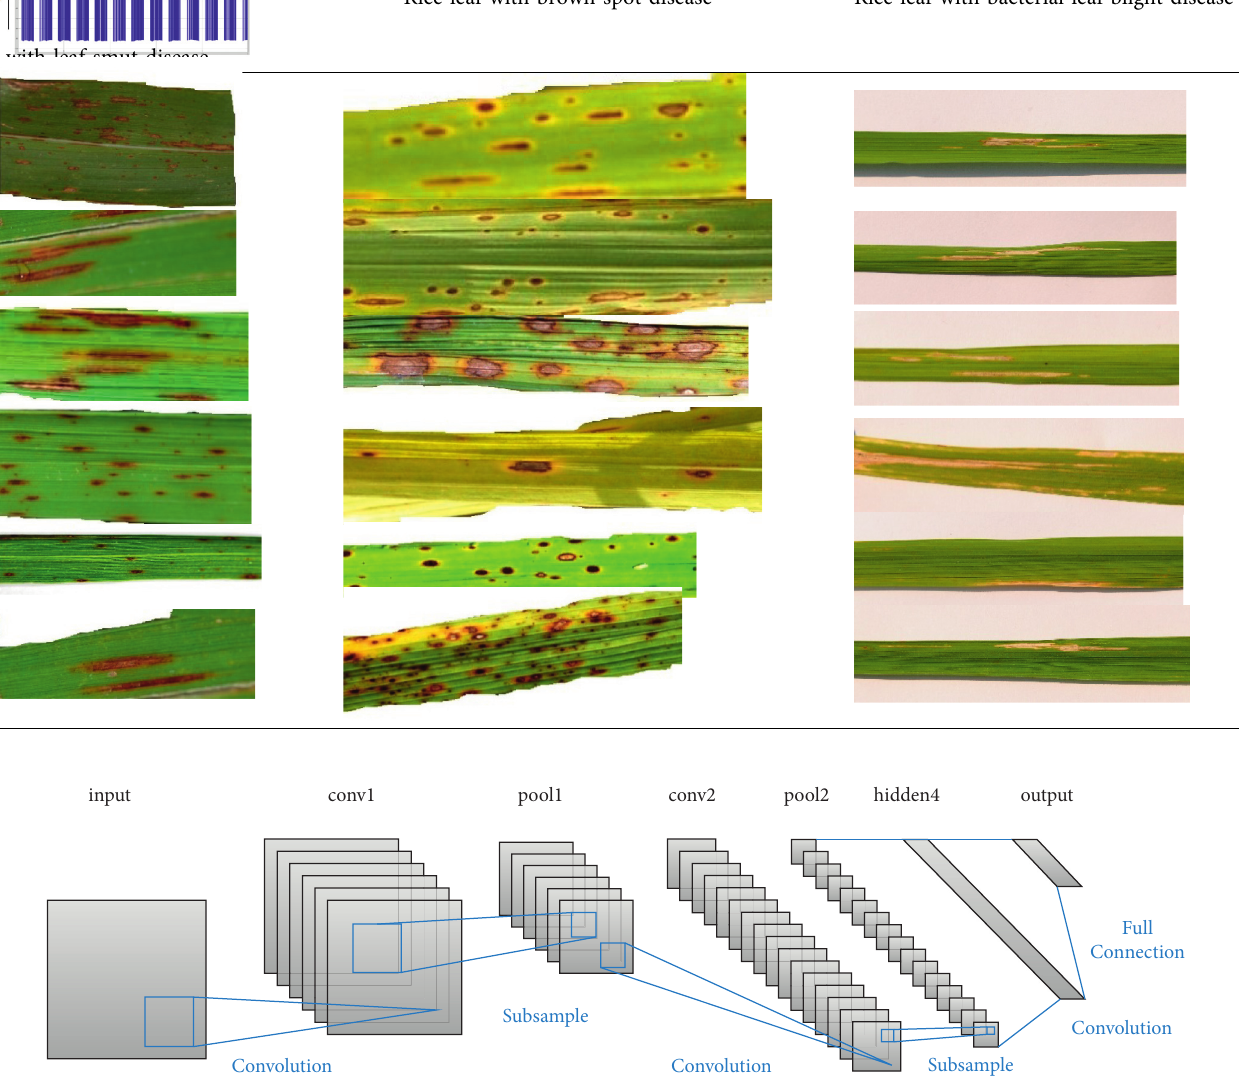
Figure 2: Typical deep convolutional neural network architecture